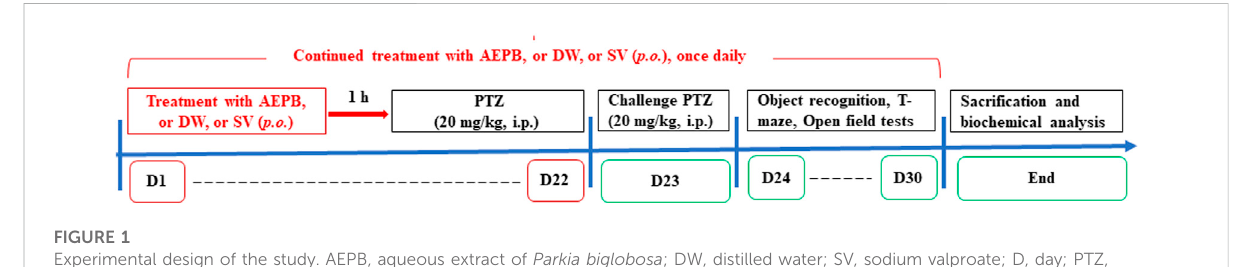
FIGURE 1 Experimental design of the study. AEPB, aqueous extract of Parkia biglobosa ; DW, distilled water; SV, sodium valproate; D, day; PTZ,